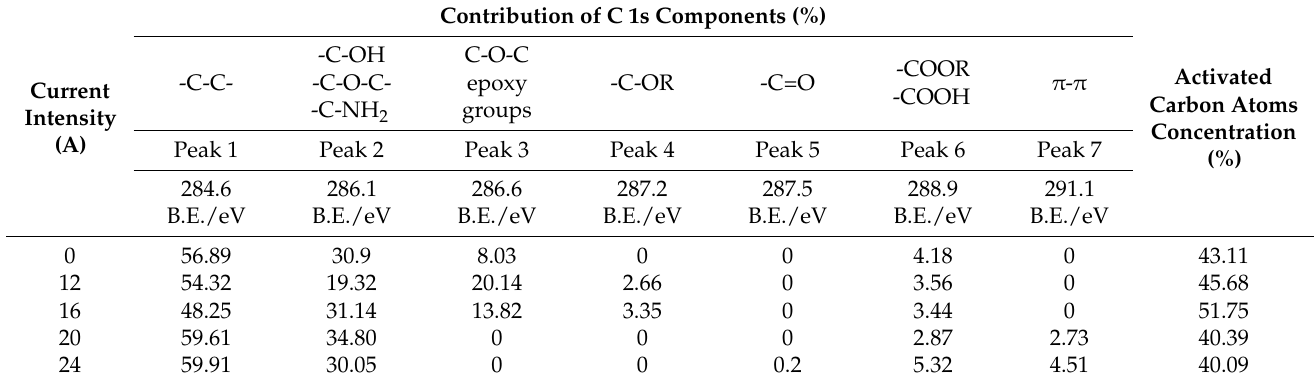
Table 2. Relative contents of functional groups on the CF